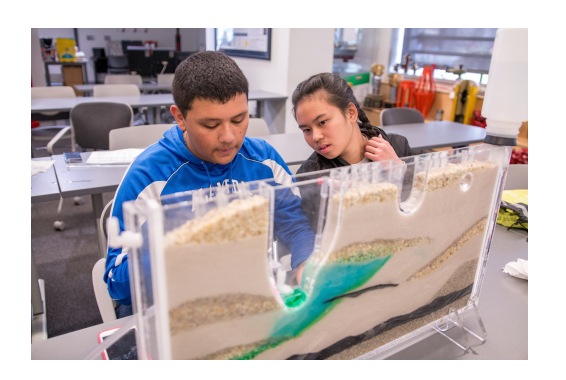
FIGURE1 Students exploring groundwater scenarios using a physical aquifer